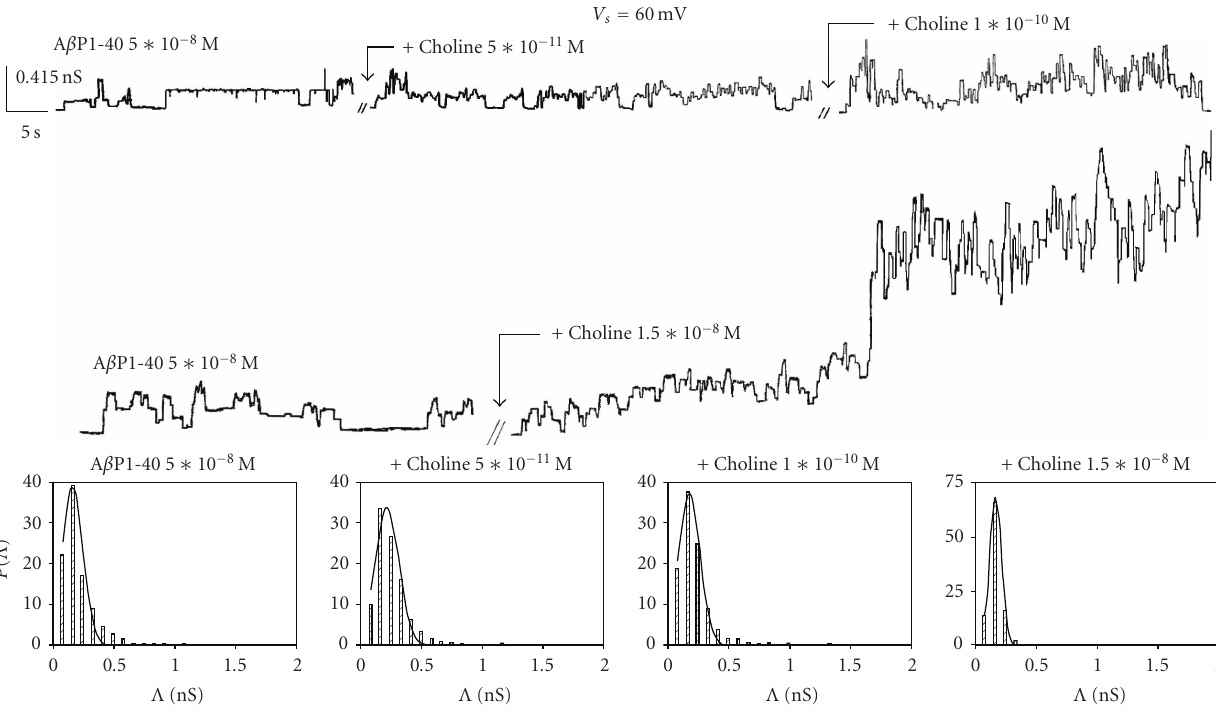
Figure 4: A β P1-40 channel activity in OxCh PLM in the absence and in the presence of di ff erent choline concentrations. Experiments were performed on an OxCh PLM in the presence of di ff erent concentrations of choline added or in the presence of high choline concentrations on the cis -side of the medium; the applied voltage was set at 60mV; the arrows indicate the choline additions when the A β P1-40 channel fluctuates in the open state. The channel central conductance (nS ± SE)/frequency (events/min ± SD) without and with choline added to the medium was: A β P1-40 = 0.161 ± 0.008/7.73 ± 0.34; A β P1-40 + choline (5 × 10 − 11 M) = 0.215 ± 0.007/15.97 ± 0.53; A β P1-40 +